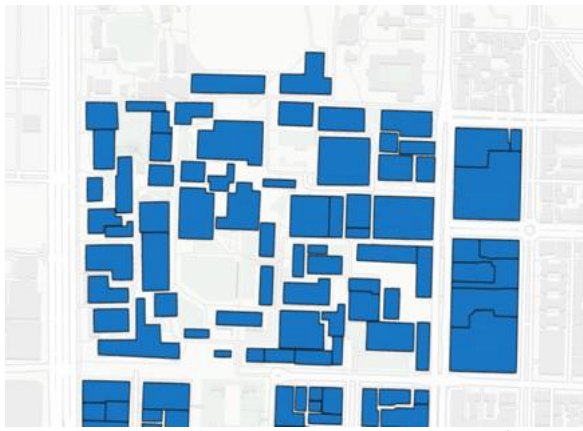
Figure 3. An example of development footprints (the blue polygons).